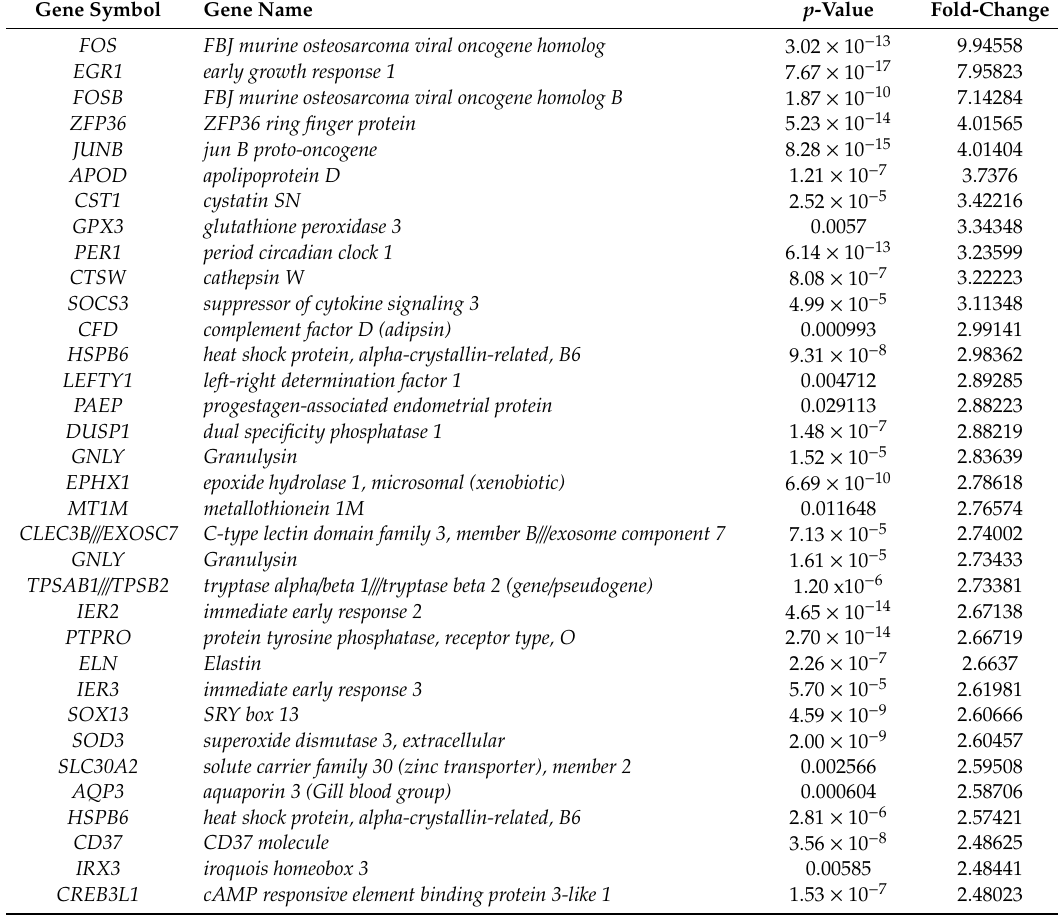
Figure 1. PCA showing two clear distinct clusters for severe endometriosis cases and normal healthy controls without uterine pathology. Table 2. Top overexpressed / upregulated di ff erentially expressed genes in